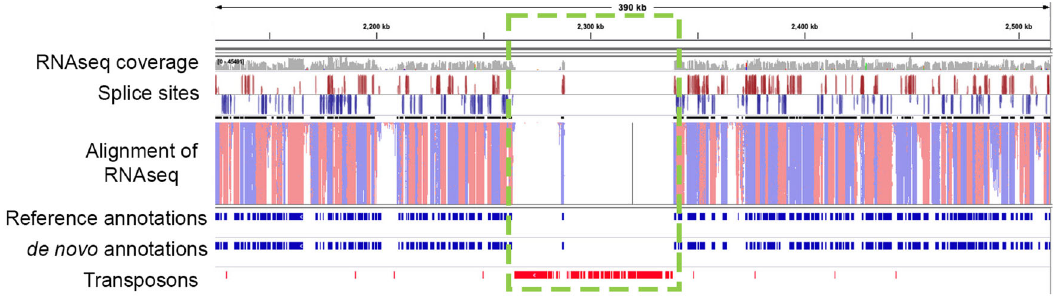
is shown in grey. Transposons are mapped using Exonerate (Transposons) with positions shown in red and the putative centromere enriched with transposons is shown in the green rectangle. Random PCR RNAseq data from NCBI was merged and mapped to genomes using HiSat2.